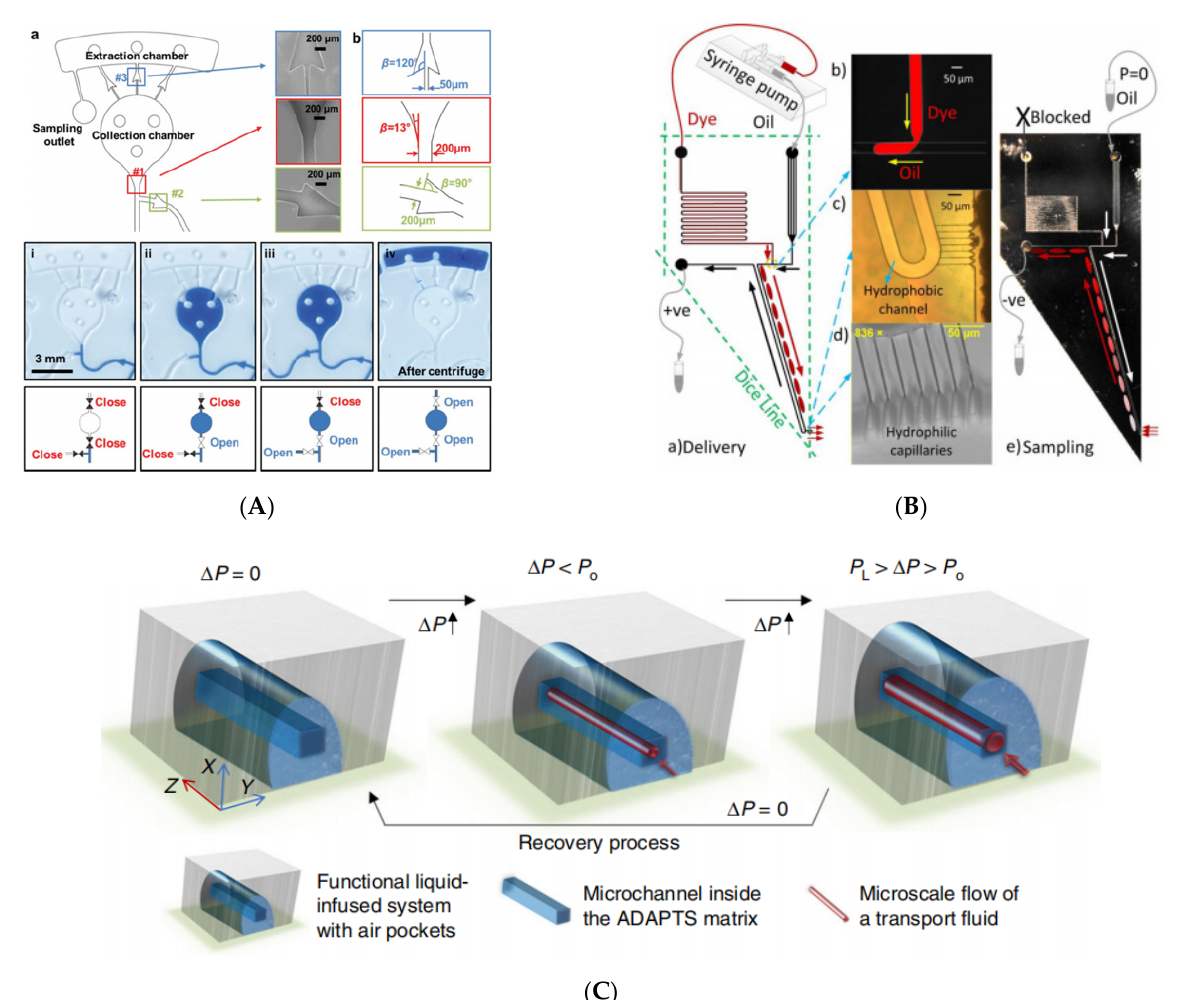
Figure 7. Use of CPCV in sampling and delivery. ( A ) A sweat sampling microfluidic device that adheres to the skin. Reprinted with permission from [150]. Copyright 2017 Wiley-VCH. ( B ) A needle-shaped liquid sampling and delivery device. Reprinted with permission from [80]. Copyright 2017 American Institute of Physics. ( C ) Surface tension applied in an adaptive air/liquid pocket transport system (ADAPTS) where the microscale flow (shown in red) is in the square microchannel (shown in dark blue). Reprinted with permission from [151].